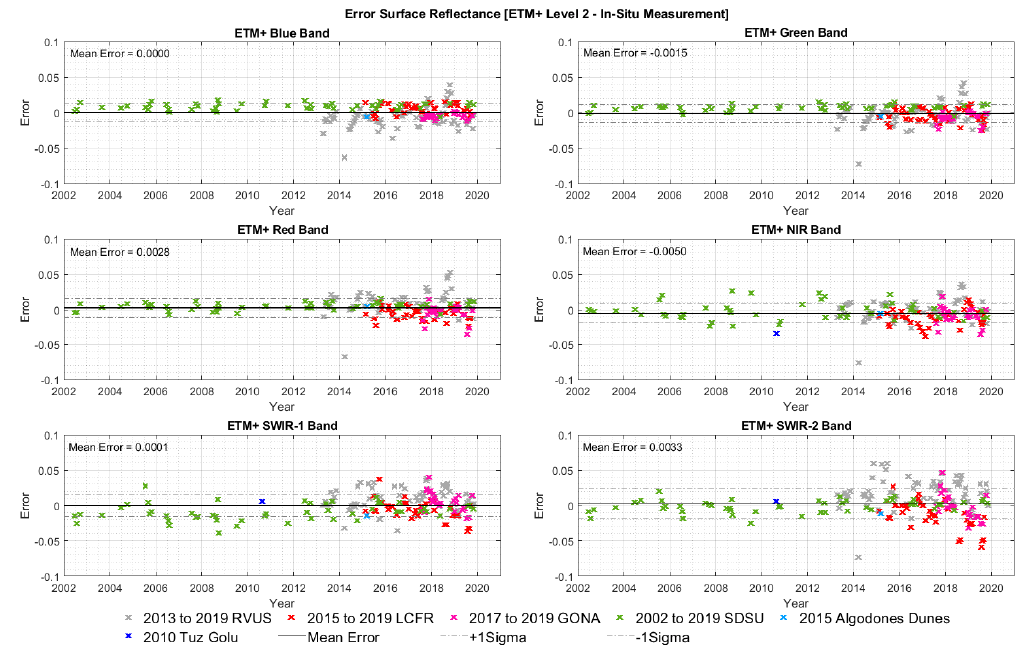
Figure 15. Scatterplots by band of Landsat-7 ETM+ Level-2 surface reflectance data product versus surface reflectance values derived from in situ measurement.